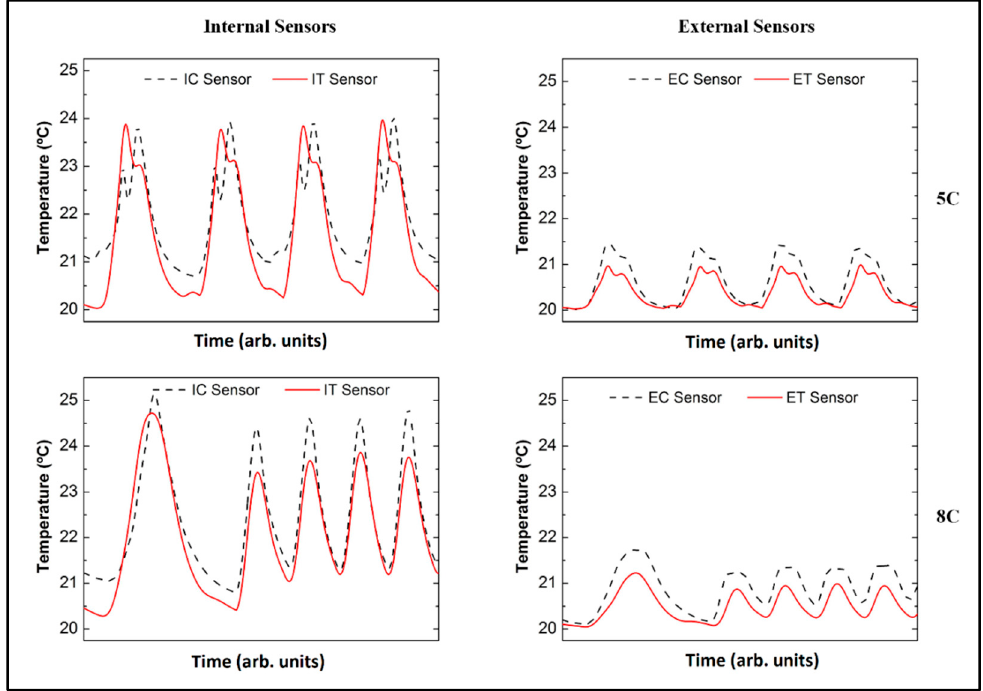
Figure 6. Temperature variations observed internally and externally at 5C and 8C.